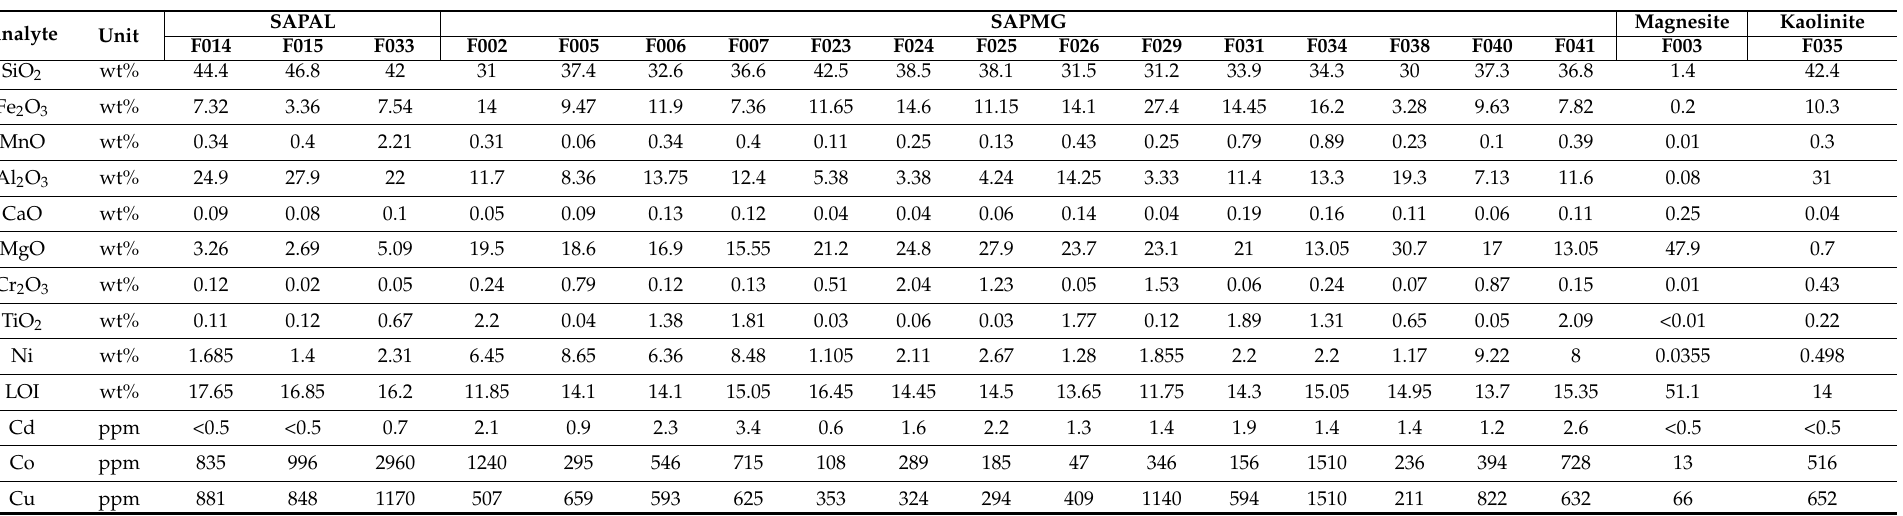
Table 2. Bulk chemical analyses of the Piau í laterite samples SAPAL, SAPMG, magnesite and kaolinite (Additional elements are presented in Table S2 of the Supplementary